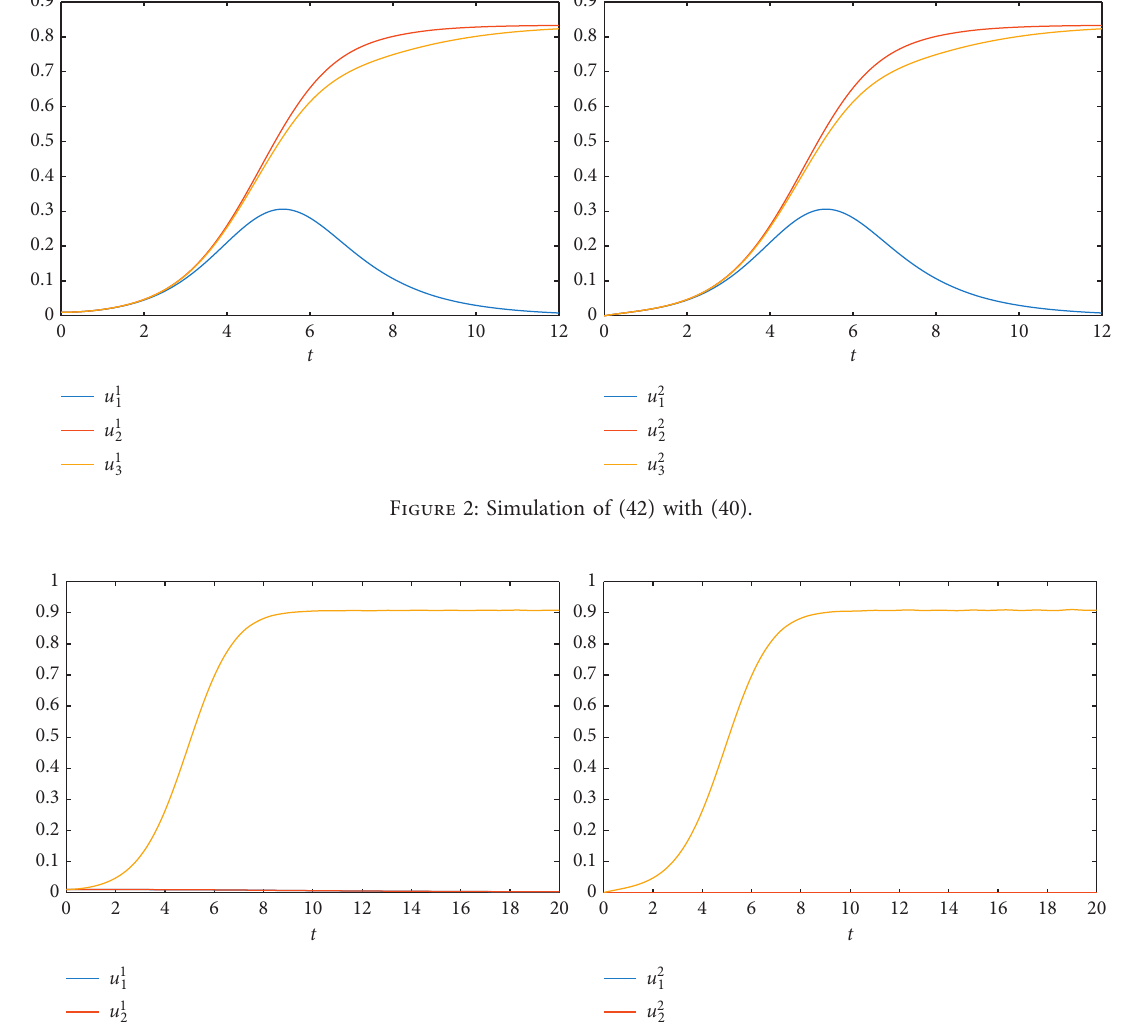
, d ,d ,d ) � ( 1 , 1 , 1 , 2 ) 1 2 3 4